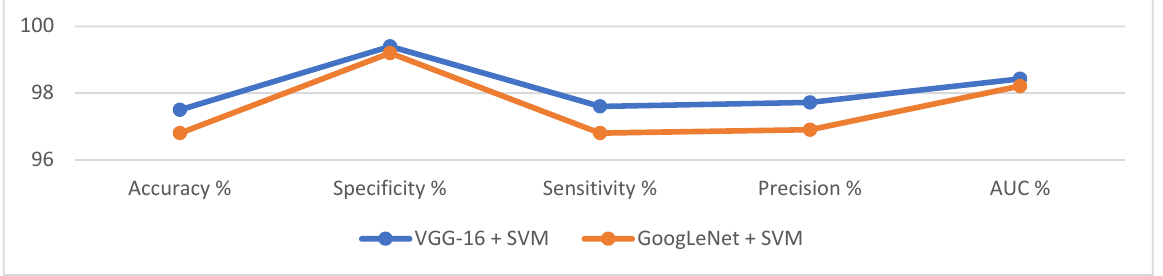
Figure 7. Display of the performance of CNN with SVM for classifying abnormal cervical cells.